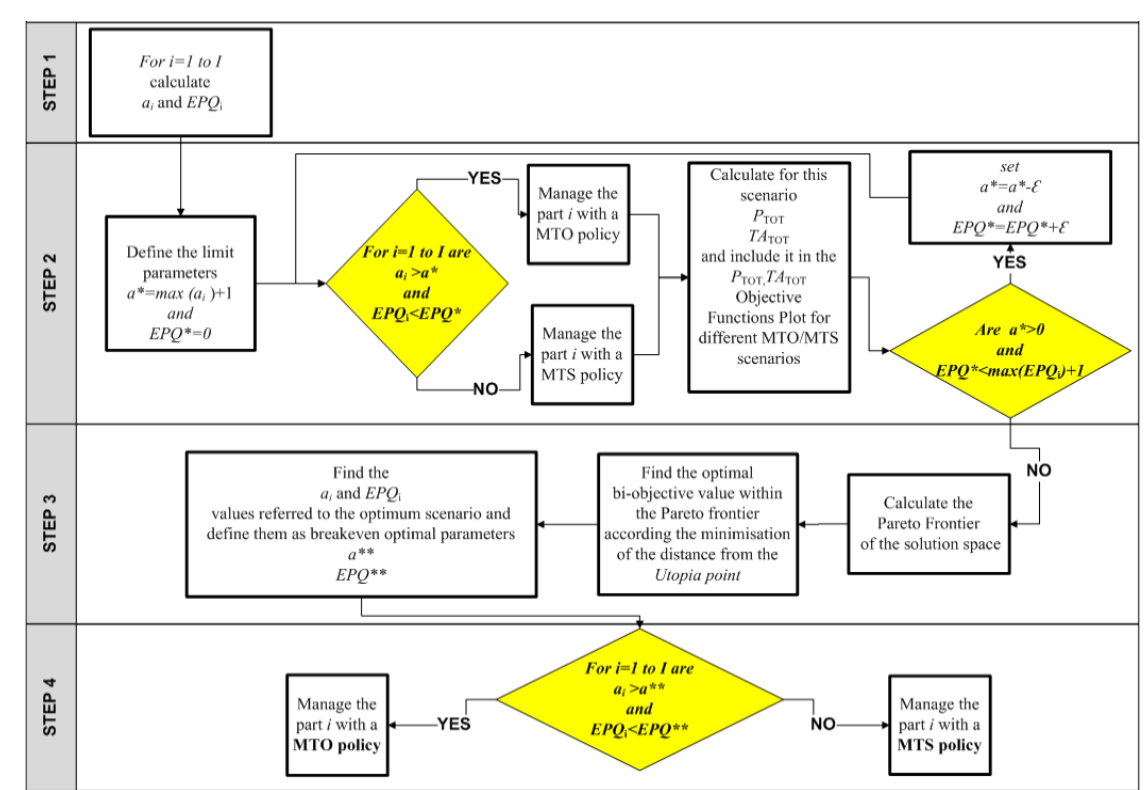
Figure 2. Algorithm for push/pull policy selection.